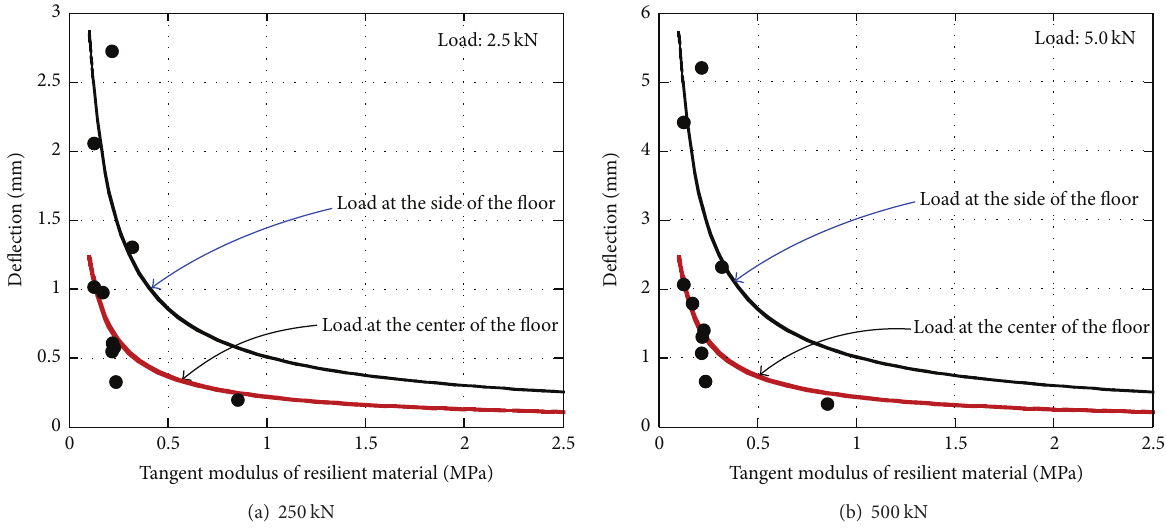
Figure 8: Comparisons of the observed and predicted deflection versus tangent modulus